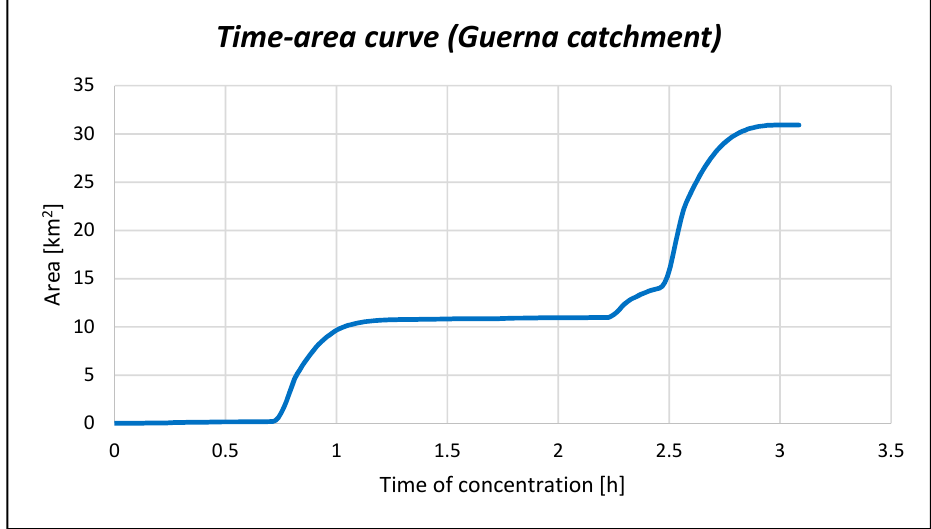
Figure 5. Time–area curve (Guerna catchment).